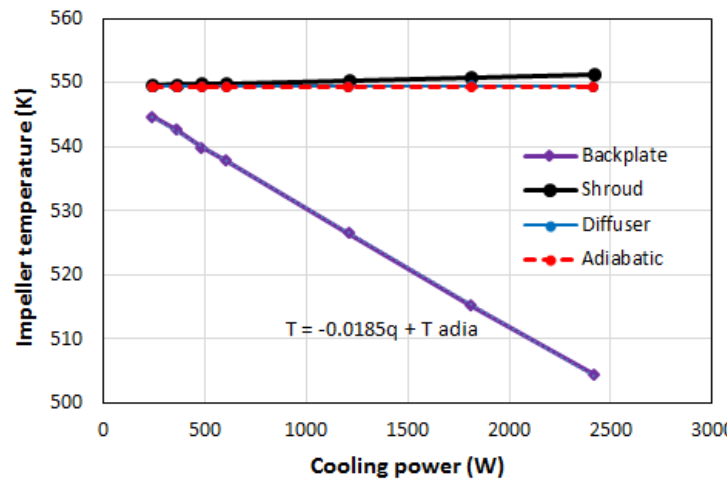
Figure 9. Temperature contours inside the compressor with cooling on different Figure 8 . Effect of cooling different walls on the impeller temperature.